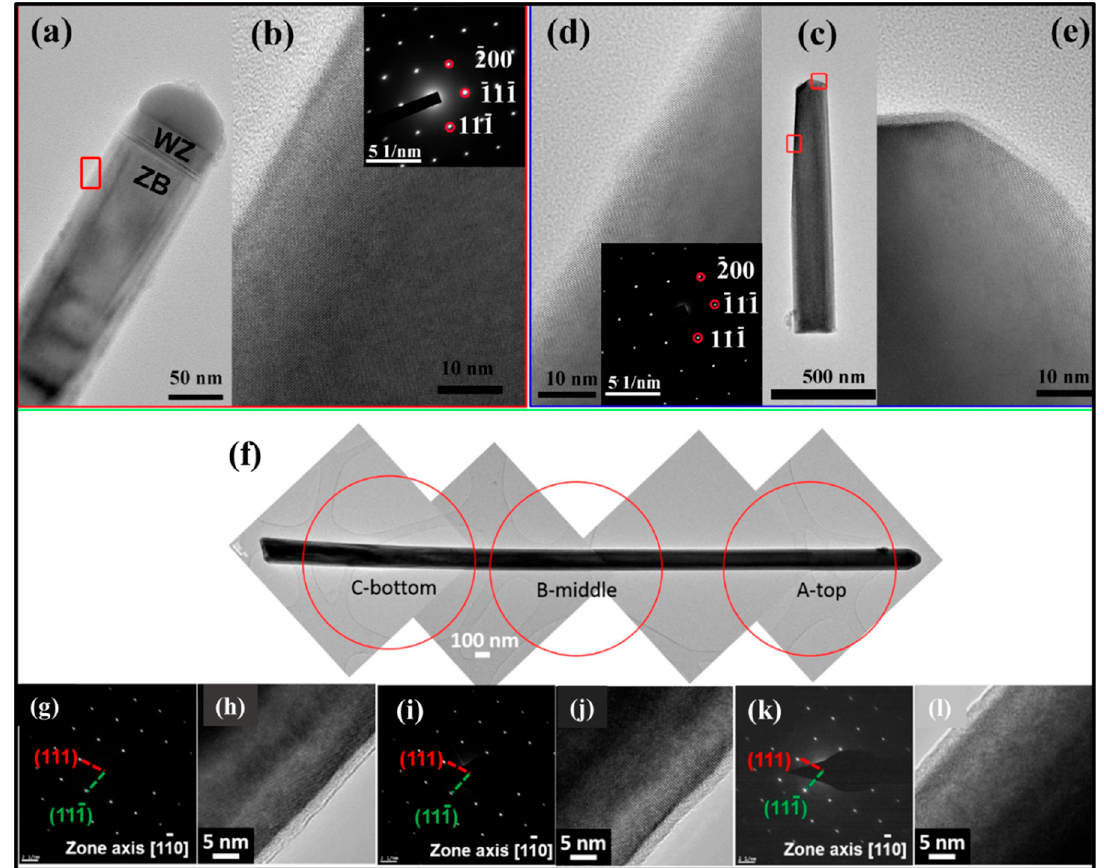
Figure 7. ( a , b ) TEM images of a GaAs 1 − x Sb x nanowire with Sb composition x sb of 0.18, ( c – e ) TEM images of a GaAs 1 − x Sb x nanowire with x sb of 0.35. Reproduced with permission from [60]; Copyright 2017, American Chemical Society. ( f ) Bright-field TEM image of 16 at.% Sb content GaAsSb nanowire. A, B, and C represent top, middle and bottom locations in the NW, respectively. HRTEM images and corresponding SAED patterns for the ( g , h ) bottom, ( i , j ) middle and ( k , l ) top segments of the nanowire, respectively (zone axis [11 ̄ 0]). Reproduced with permission from [61]; Copyright 2017, IOP publishing Ltd.